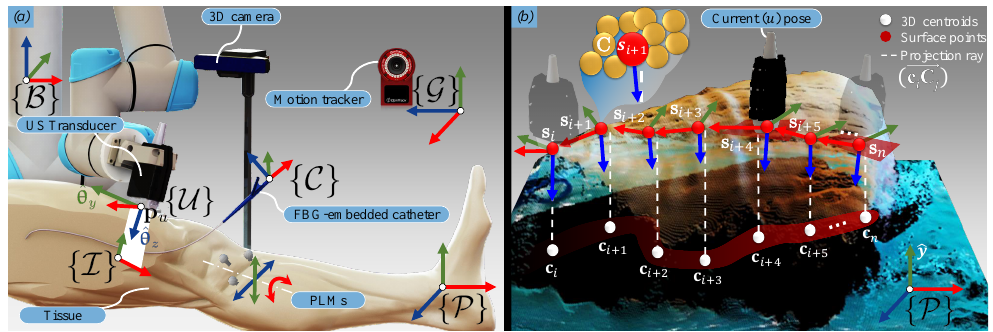
Figure 3. Intra-operative ultrasound (US) transducer pose planning. ( a ) In this study, we integrate three imaging modalities: a 3D depth camera, a US transducer, and a motion tracking system. Additionally, data from the Fiber Bragg Grating (FBG) sensors are fused with imaging data to provide real-time shape information of the endovascular catheter. This information is combined with the reconstructed environment from the pre-operative planning to visualize the catheter inside the arterial volume, which is subjected to Periodic Limb Movements (PLMs). All reference frames are indicated in brackets ( ). ( b ) Surface points ( s i ) are obtained by vertically projecting the arterial centroids {} ( c i ) obtained from Algorithm 1, and finding the closest point on the surface point-cloud dataset ( C j ). A trajectory for the US transducer is then calculated along the tissue surface. A proportional-integral (PI) controller positions the transducer, while its orientation is controlled by a P-controller. Together, these controllers realize the pose of the transducer (obtained from Algorithm 2) at a 3D surface target